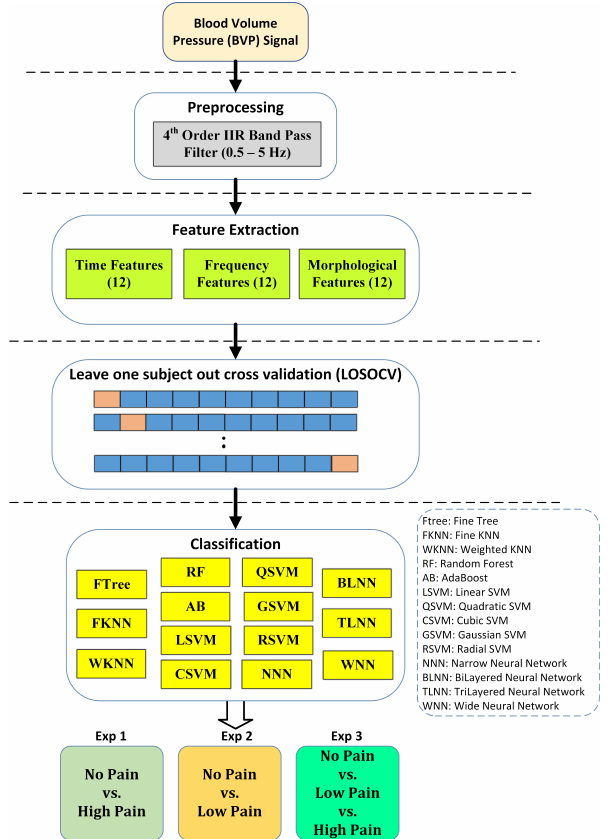
Figure 5. Design of study for assessment of pain using BVP signatures. Performance results are reported using the five most consistent